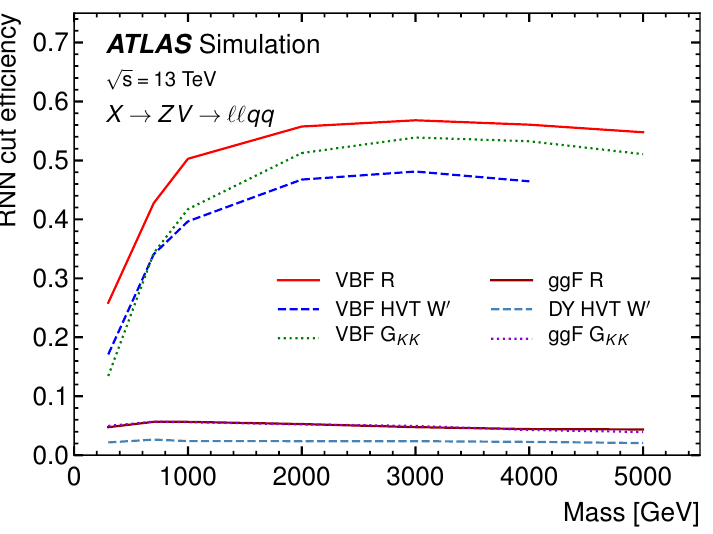
Figure 8. The fractions of signal events passing the VBF requirement on the RNN score as functions of the resonance mass for both VBF and GGF production in the 2-lepton